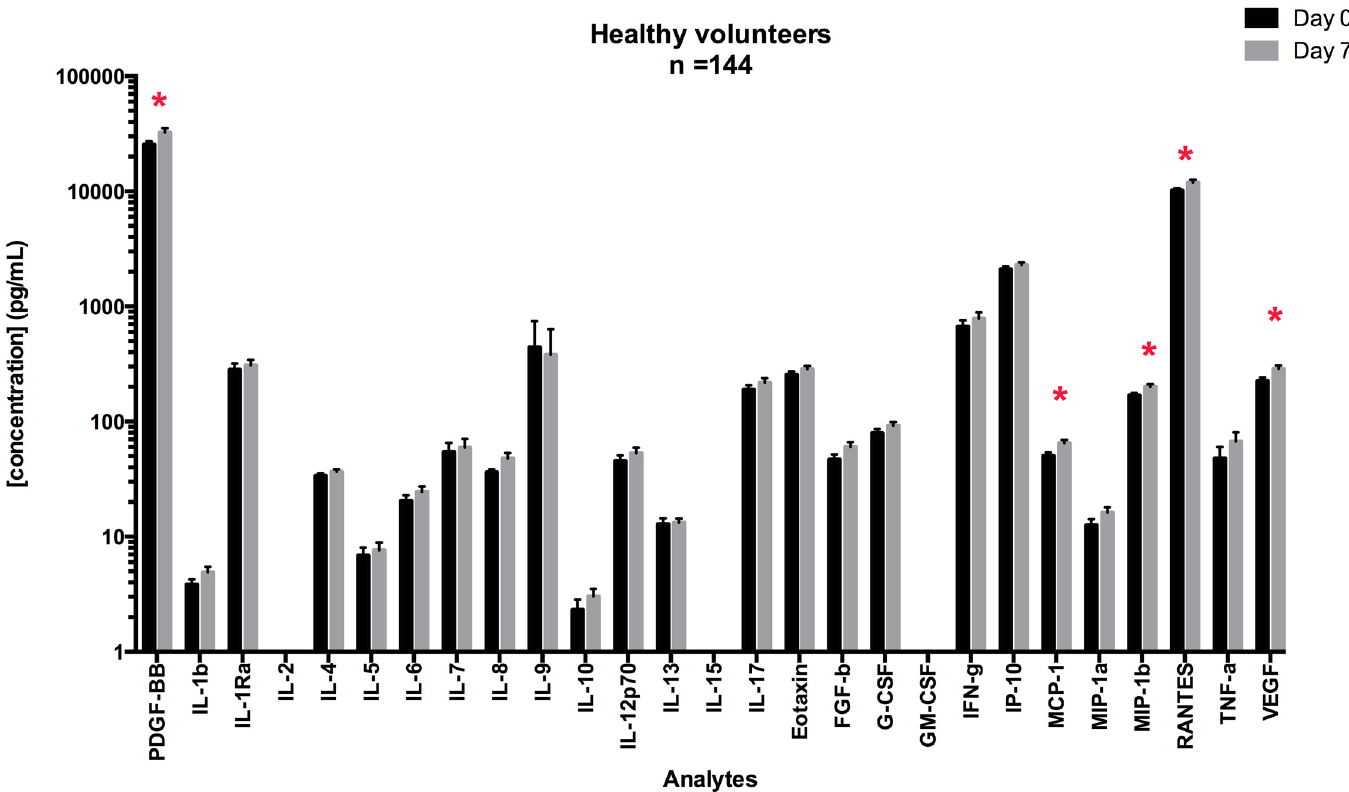
Fig 2. Mean concentrations for cytokines in serum samples at Day 0 and Day 7. Serum cytokine concentrations were measured on matched samples at Day 0 and Day 7. Paired T-tests were performed to measure the significance of the difference of the mean between Day 0 and Day 7. Cytokines for which % CV is higher than 20% are shown with “ * ”